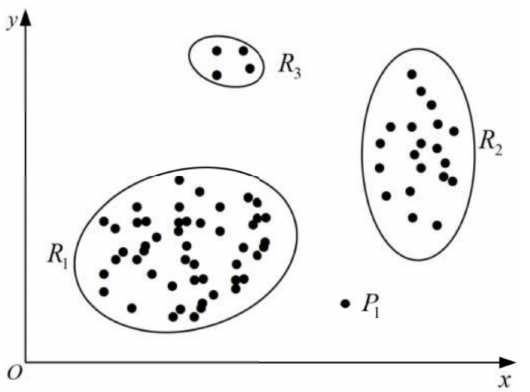
Figure 1. An example of two-dimensional data anomaly